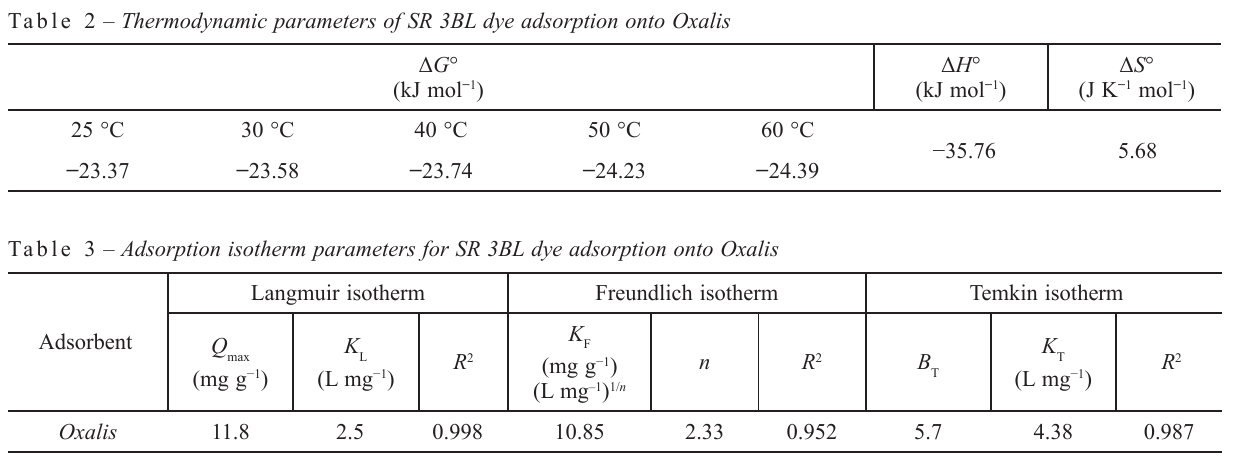
Table 2 – Thermodynamic parameters of SR 3BL dye adsorption onto Oxalis